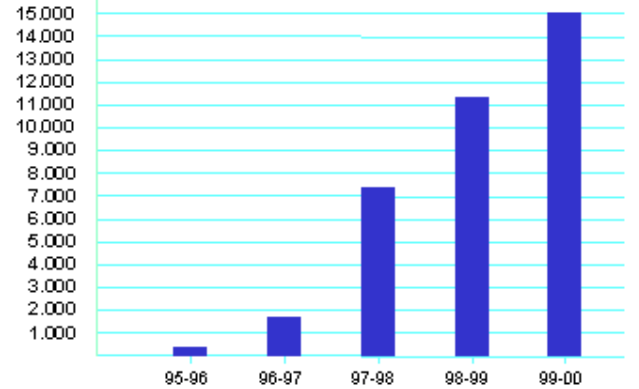
Table 2. UOC Student Enrolment 1995 to